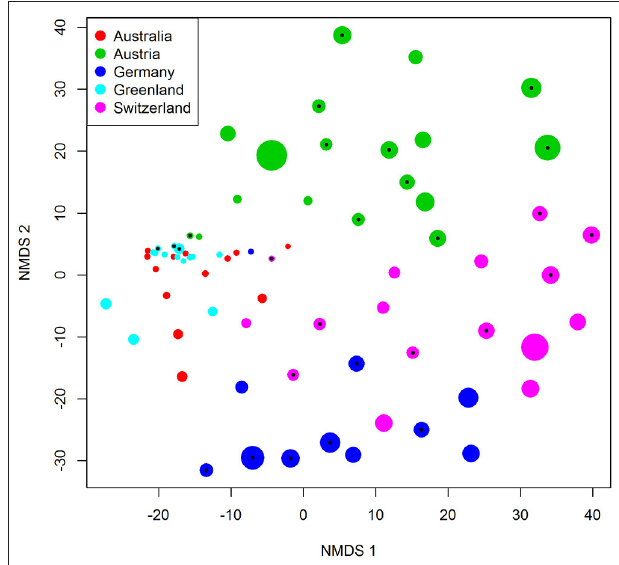
FIGURE 3 | NMDS ordination of the pilot data. Each dot corresponds to one sample. The color indicates sampling location, the size of the sample corresponds to the amount of DNA (measured by w i ), while the black dots mark samples that contained an insect. The final stress achieved in the NMDS was